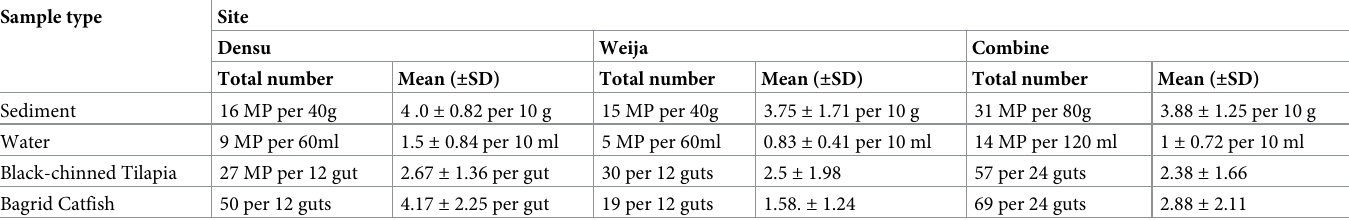
Table 2. Summary data on number of microplastics in sediment, water, Black-chinned Tilapia and Bagrid Catfish from Densu Delta and Weija Dam in Ghana. Sample